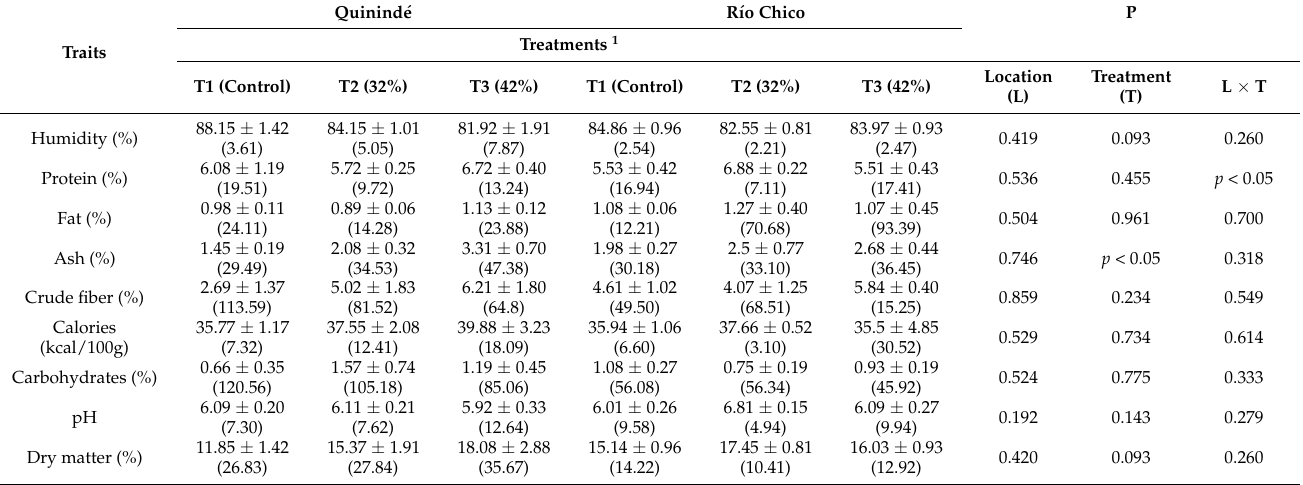
Table 6. Chemical analysis of ileum content (mean ± standard error (coefficient of variation)) in backyard pigs fed with cooked cassava and taro in two locations in Ecuador (Quinind é and R í o